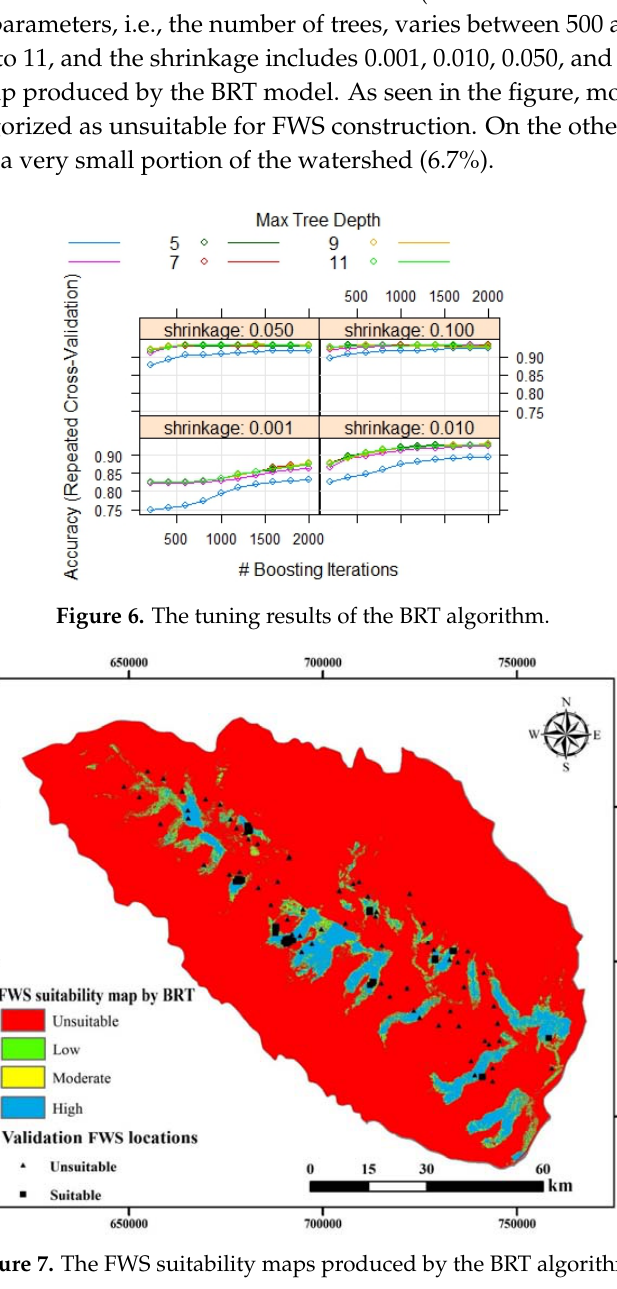
Figure 7. The FWS suitability maps produced by the BRT algorithm.